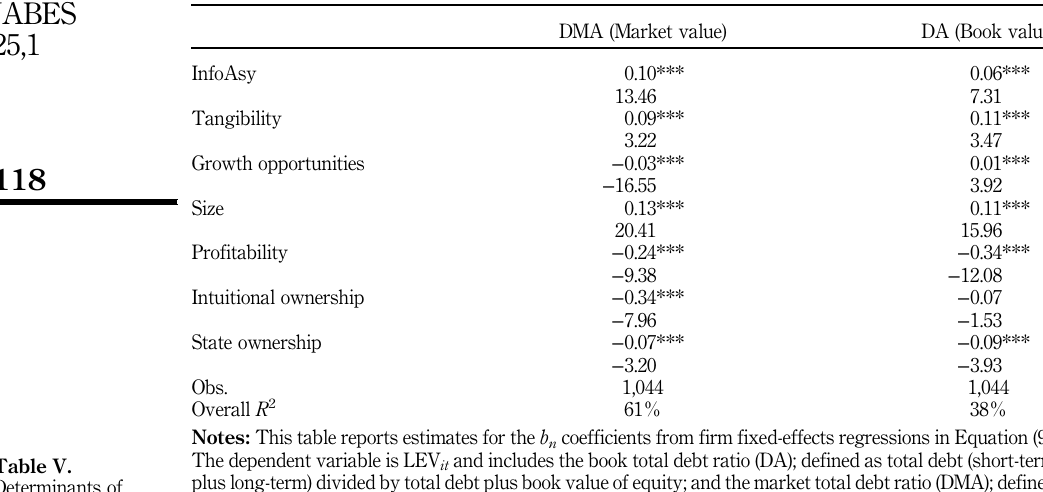
Chinese capital